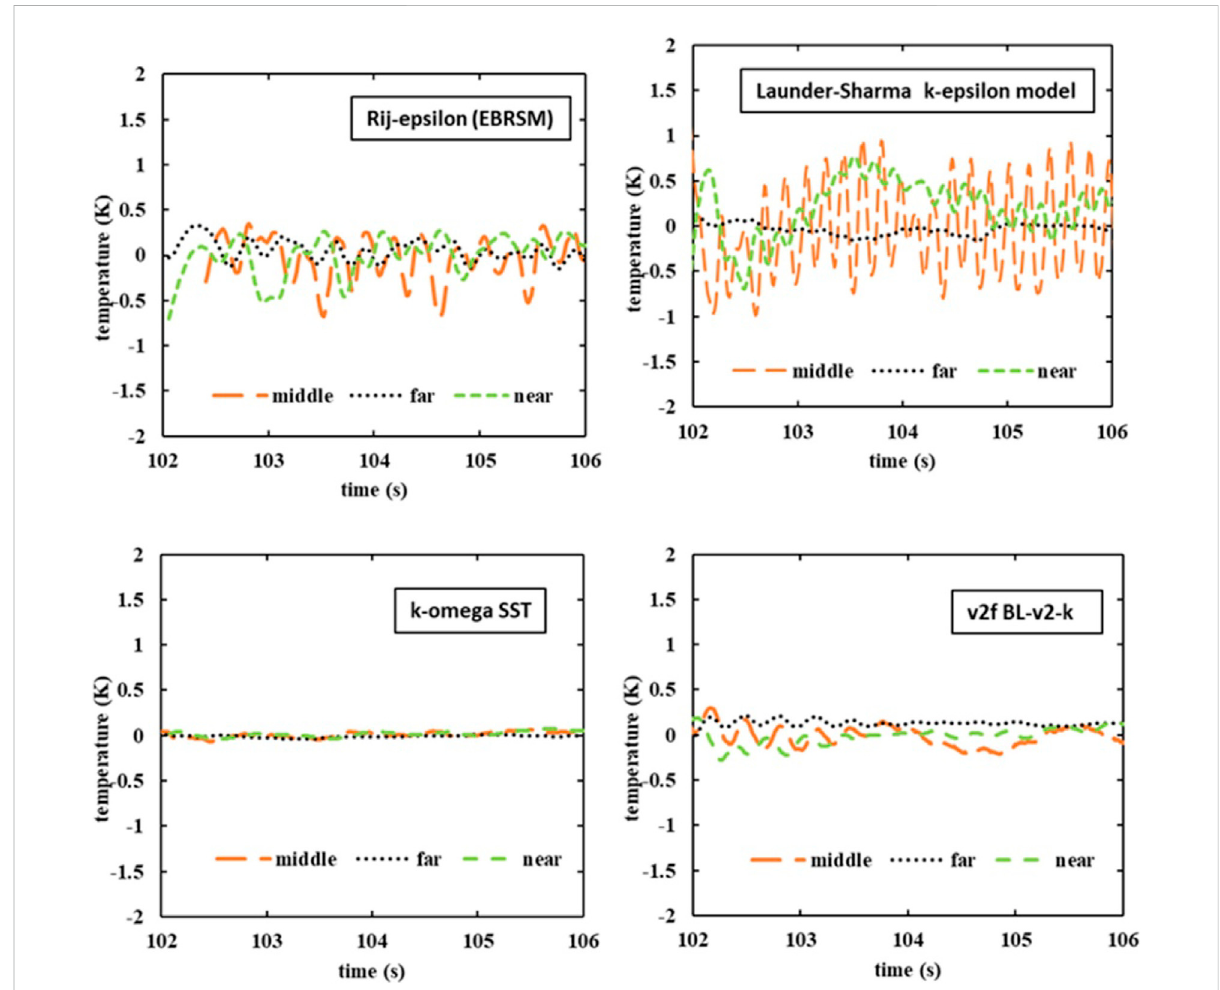
FIGURE 11 Temperature variations with time with different turbulence